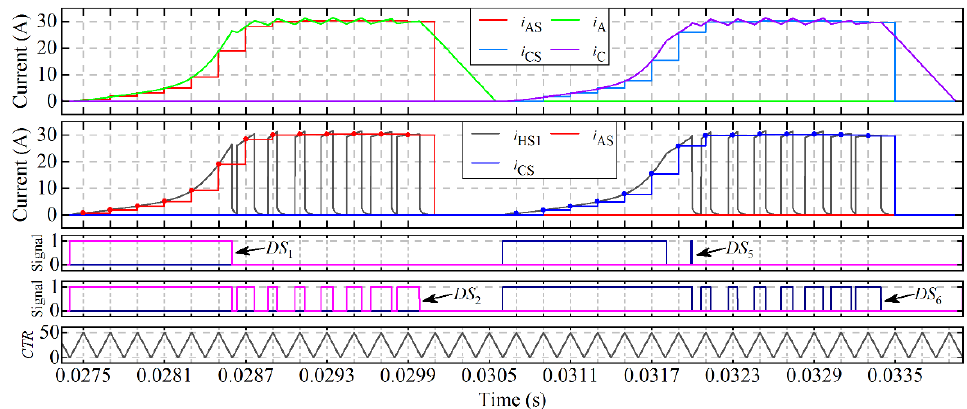
Figure 15. Simulation waveforms at − 1500 rpm ( i * = 30 A) with the proposed N p /2 sensors-based current detection scheme.